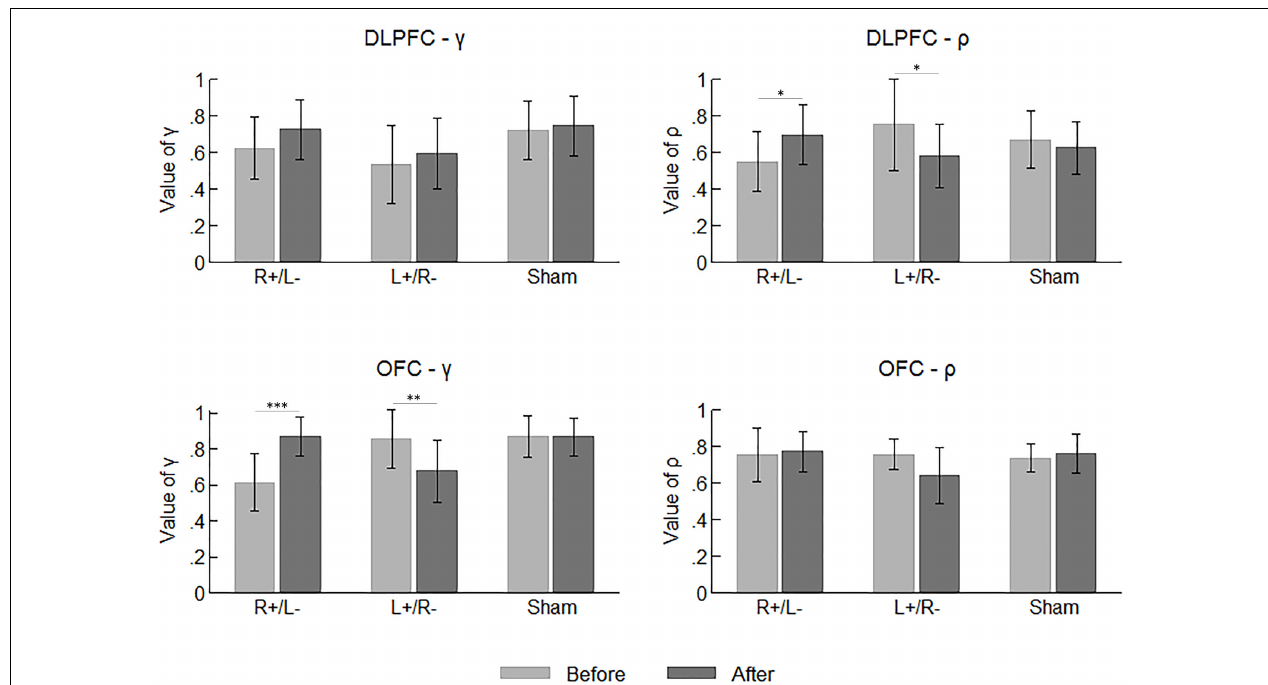
decreased the participants’ preferences for ambiguity. The reversed effect was also observed in the reversed tDCS on the two areas.